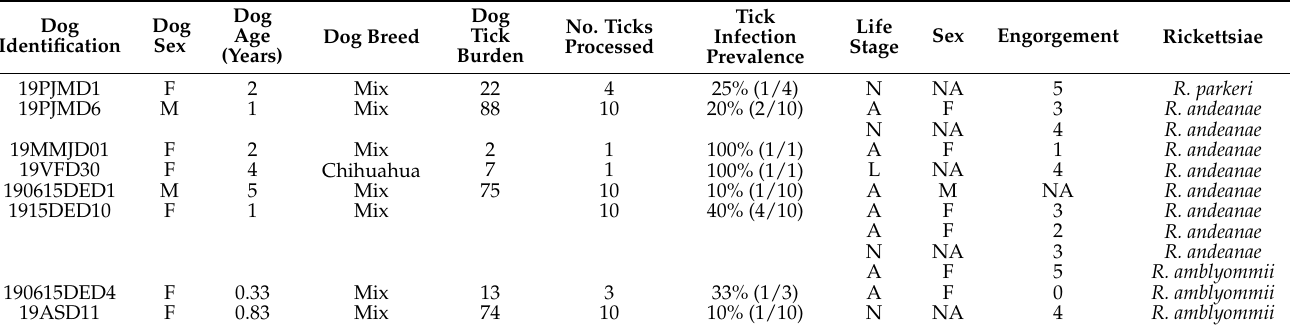
Table 3. Host and tick attributes for ticks infected with Rickettsia species from Reynosa, northeast- ern M é xico.